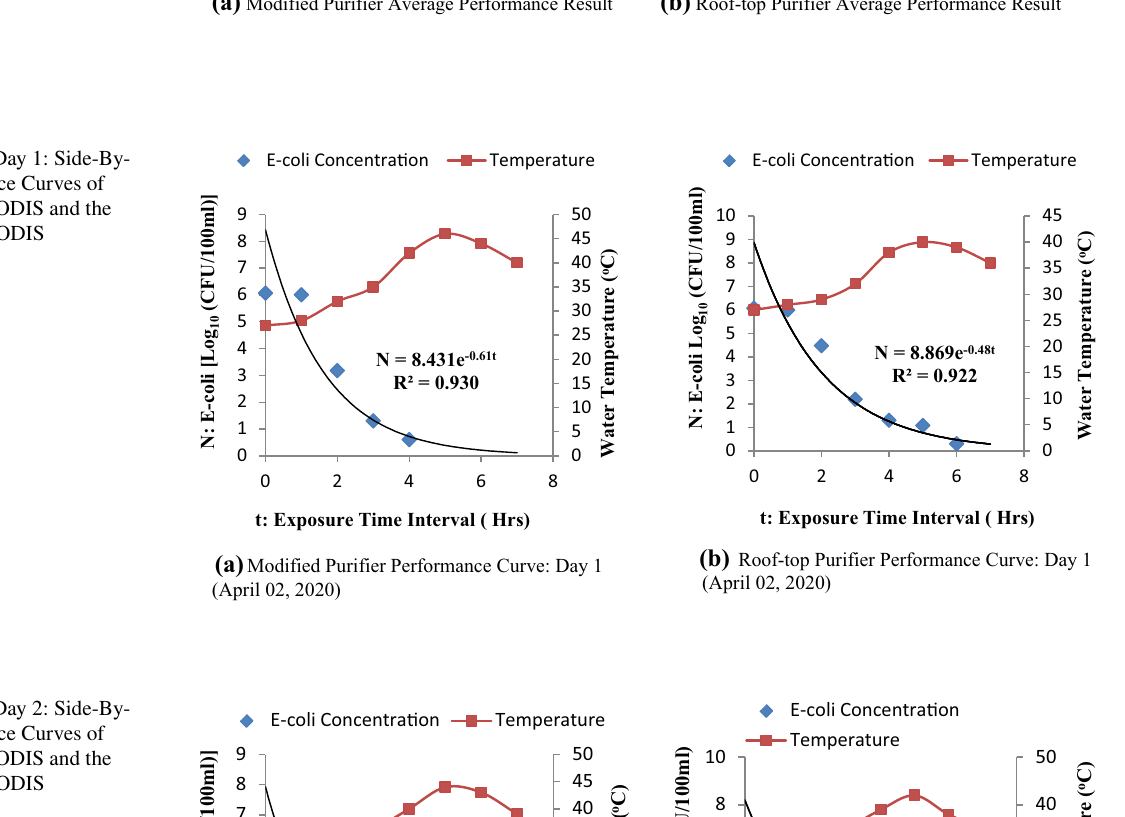
N = 13.88e -0.55t R² =